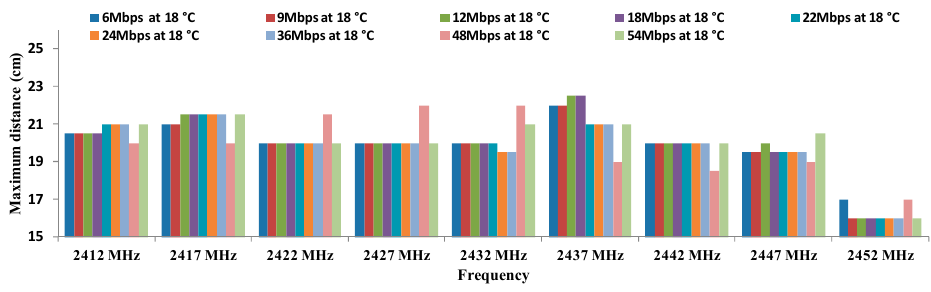
Figure 12. Maximum distances for OFDM at 18 °C.